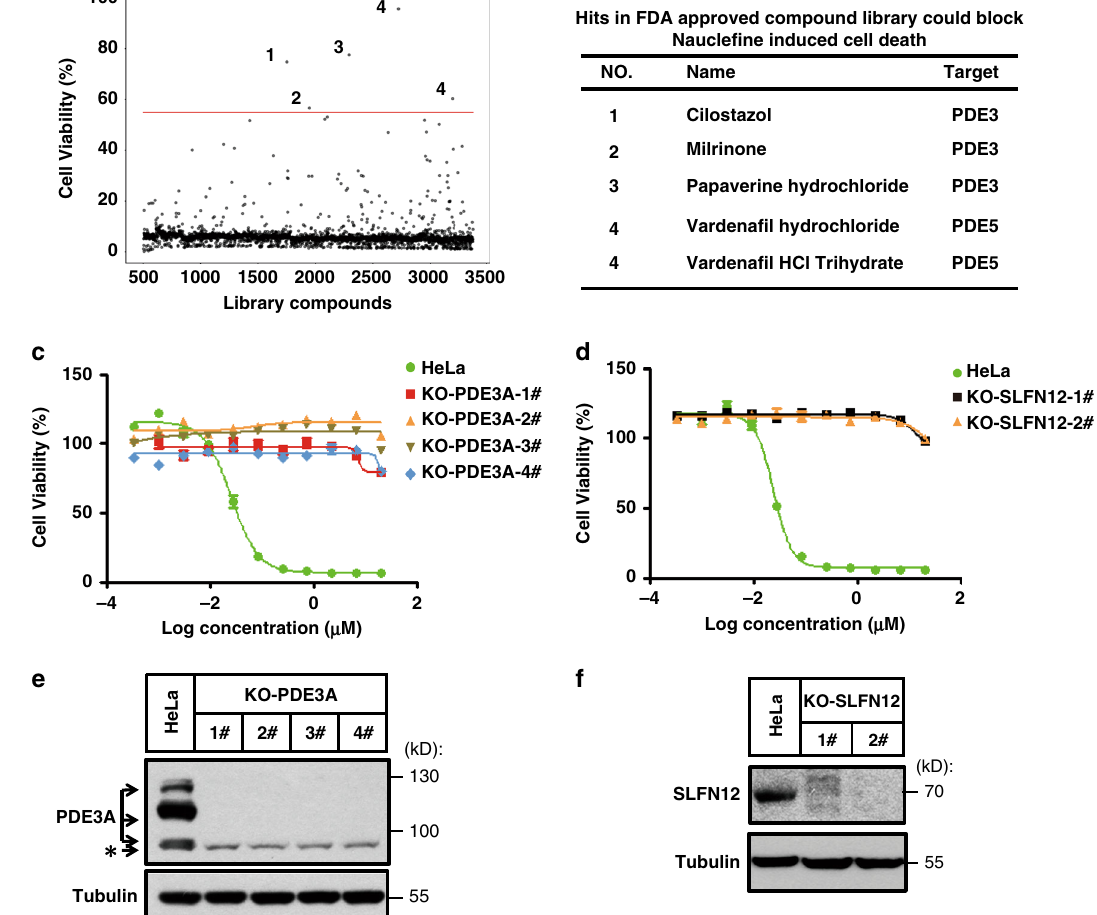
Fig. 2 Naucle fi ne-induced cell death requires expression of PDE3A and SLFN12 in HeLa cells. a Primary screen results of cell viability protection by compounds of the FDA-approved library. Compounds 1 – 4 were potential hits that potently protect against naucle fi ne-induced cell death. b The name and previously known targets of FDA-approved compounds 1 – 4. Indicated concentrations of naucle fi ne used to treat HeLa cells with PDE3A knocked out ( c ) or SLFN12 knocked out ( d ) for 48 h. ATP levels were measured to assess cell viability. Data shown are from two independent experiments (with n = 4 wells each time). Expression of PDE3A ( e ) or SLFN12 ( f ) was knocked out using the CRISPR-Cas9 system, and was veri fi ed by western blotting. The western blot presents representative results from two